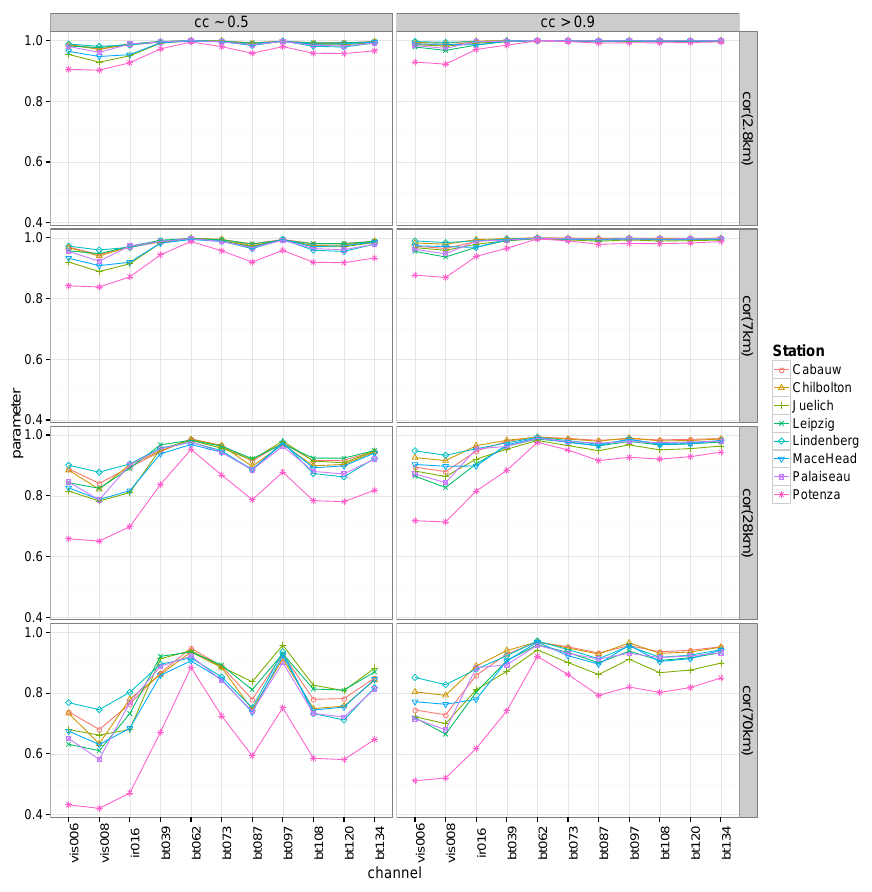
Figure 8. Same as Fig. 7 but for daily means of SEVIRI